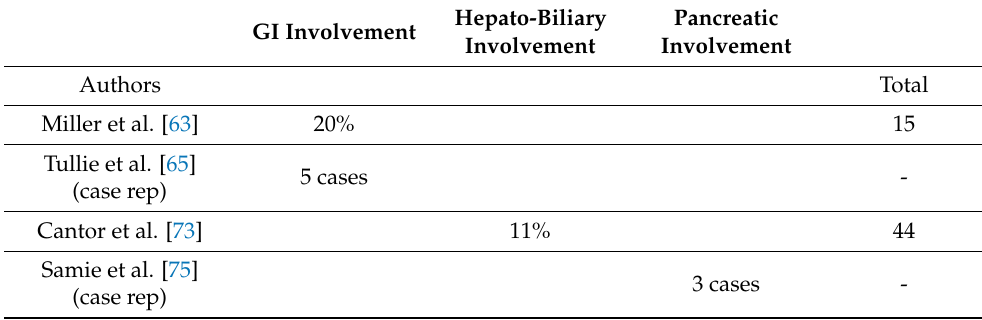
Table 4. Pediatric “Abdominal” COVID-19